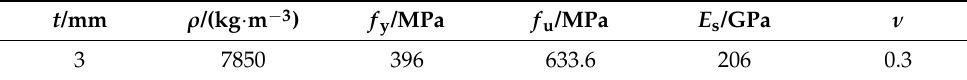
Table 2. Material parameters of steel.